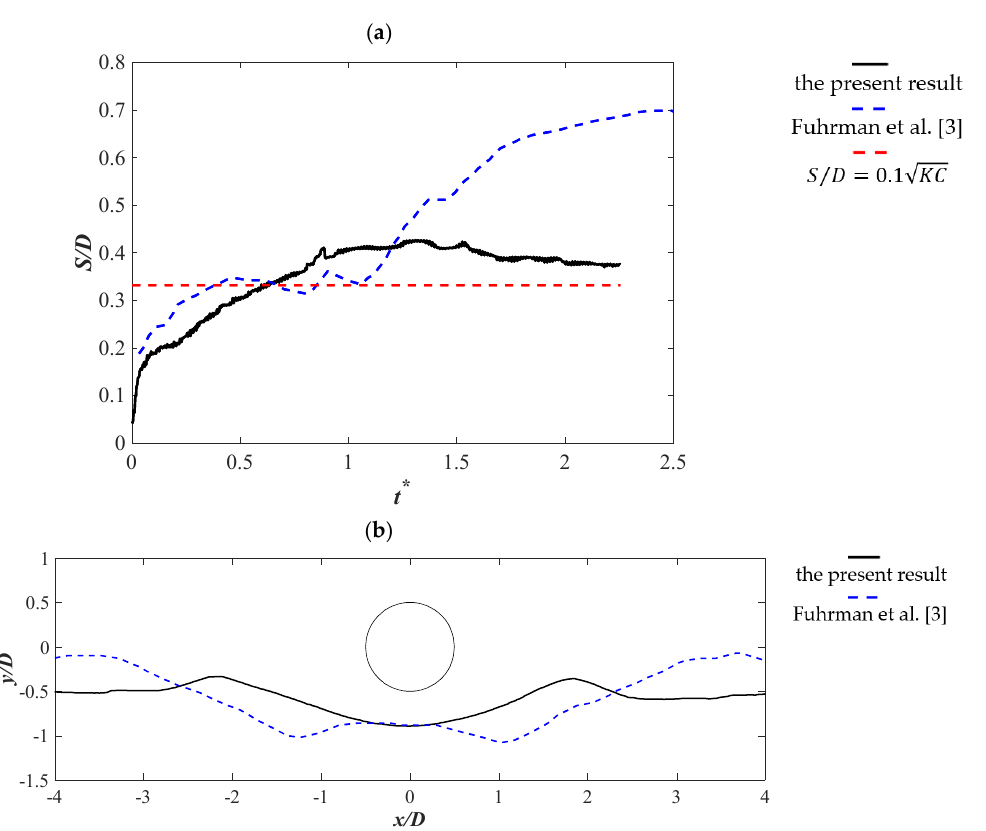
Figure 6. ( a ) The time history of the maximum scour depth for the present study (solid black line) compared with that reported by Fuhrman et al. [3] (data adapted from Fuhrman et al., 2014, blue dashed line) and the data predicted by the empirical relationship of S / D = 0.1 √(cid:1837)(cid:1829) (red dashed line); ( b ) the present predicted sediment profile (black) compared with that reported by Fuhrman et al. [3] (blue dashed line) at (cid:1872) ∗ = 0.9 .